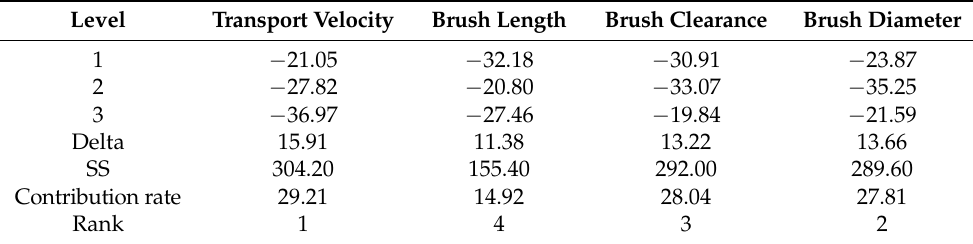
Table 6. Response table for damage S/N ratios of circular-shaped cherry